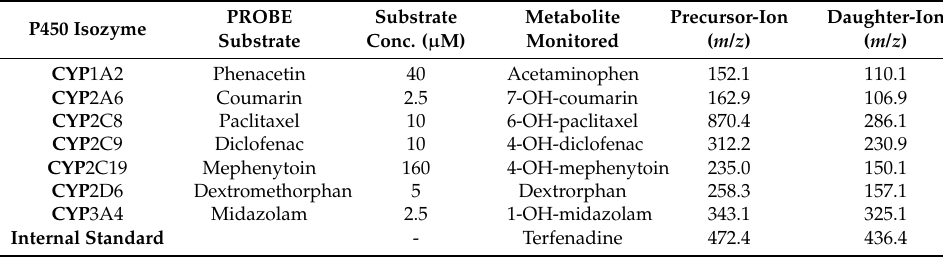
Table 1. Information on the probe substrates and their corresponding CYP-specific metabolites used in this study. P450